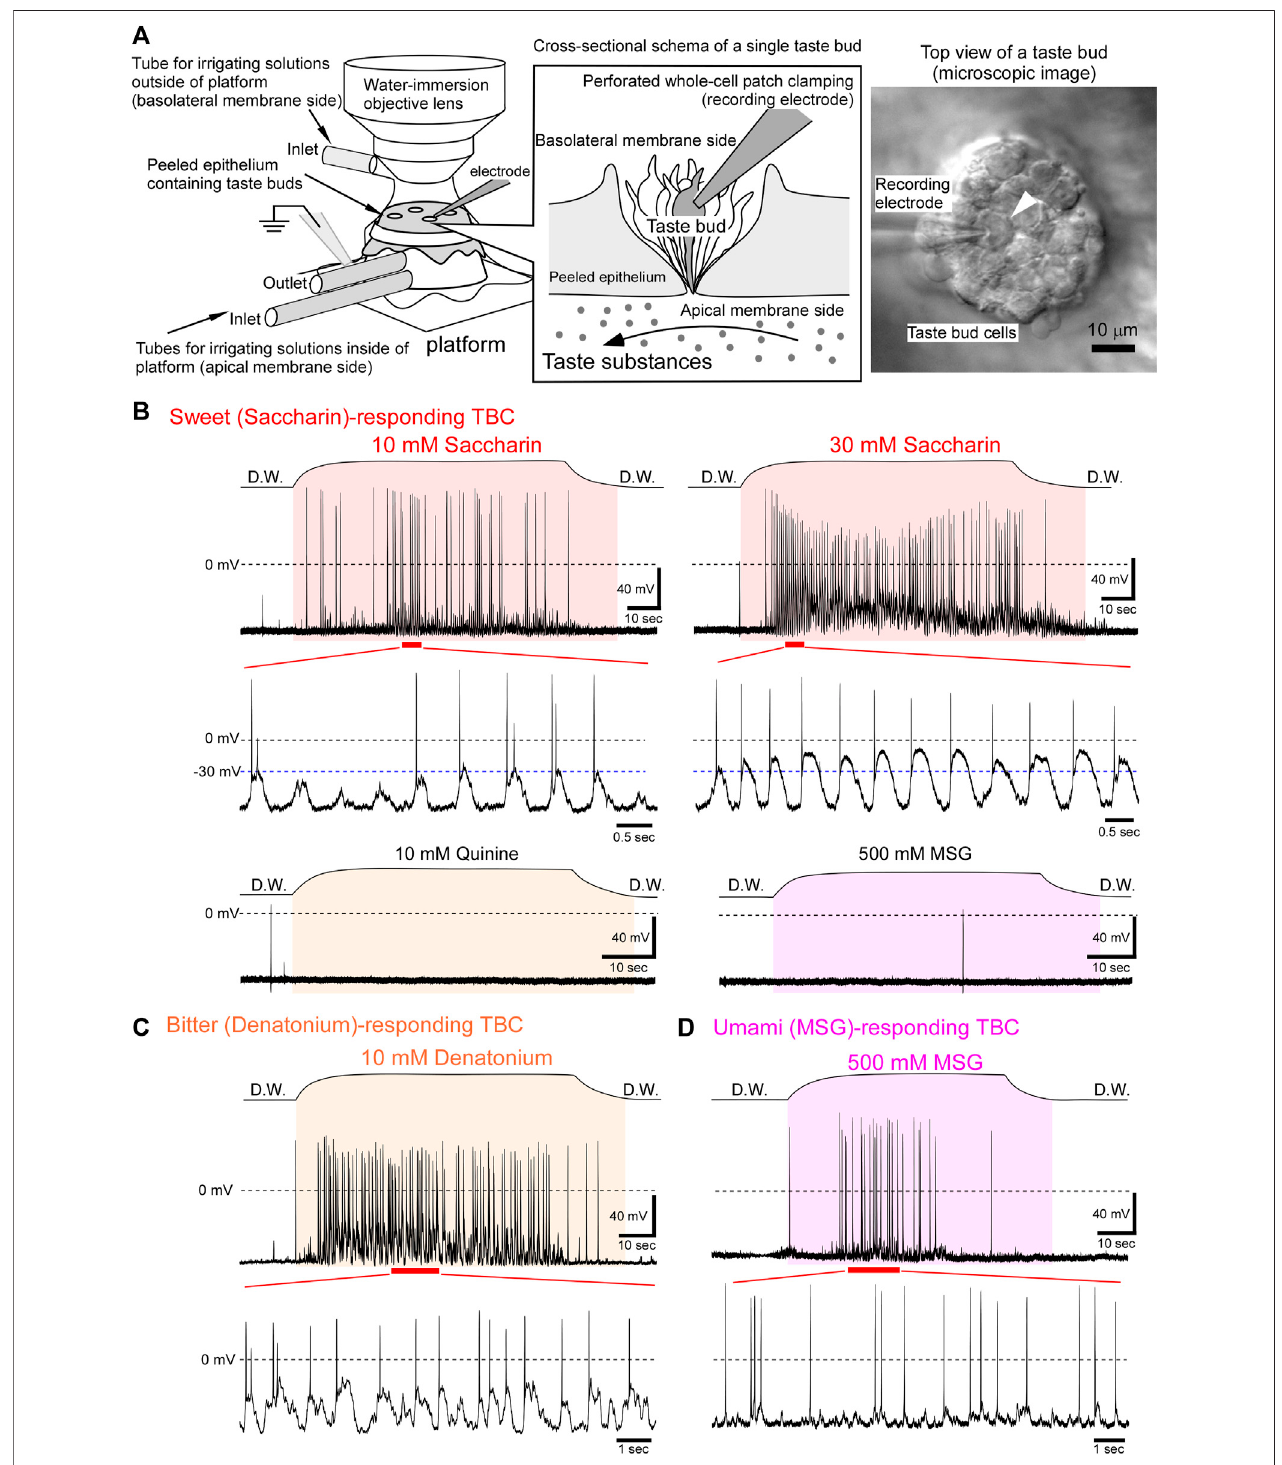
FIGURE1| Oscillatingreceptorpotentialstosweet,bitter,orumamitastesubstances. (A) Experimentalsetupforperforming insitu perforatedwhole-cellrecording from fungiform TBCs. Each taste substance dissolved in deionized water was applied only to the apical membranes through tubes connected to the platform. A differential interference contrast image of the basolateral membrane side of TBCs (right image). Under visual guidance, the recording electrode was placed on a single TBC(arrowhead), and then the perforated whole-cell recording was performed. (B) A sweet taste substance, saccharin, generated oscillating depolarizations with action potentials. This TBC responded to saccharin in a concentration dependent manner, although it did not respond to 10 mM quinine and 500 mM MSG. (C) A TBC responded toabittersubstance andgeneratedoscillations with fi rings. (D) An umami tastant inducedoscillating receptor potentials with fi rings. Theperiod betweenthe beginning and end of taste stimulation is indicated in the colored fi ll patterns. D.W, deionized water.